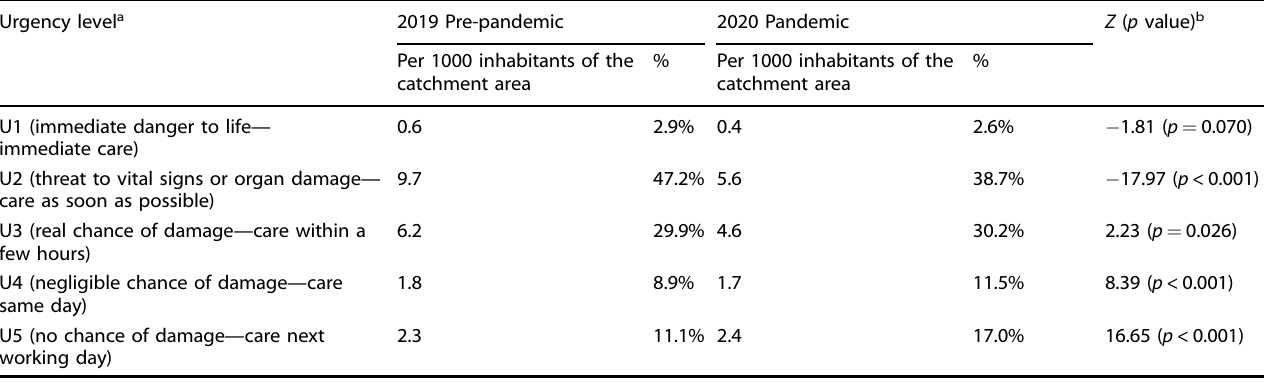
Table 4. The distribution of urgency levels at OOH services for asthma/COPD, displayed per 1000 inhabitants of the catchment area and the proportion of the distribution, for phases 1 – 3 in 2019 (before the COVID-19 pandemic) and phases 1 – 3 in 2020 (during the COVID-19 pandemic).